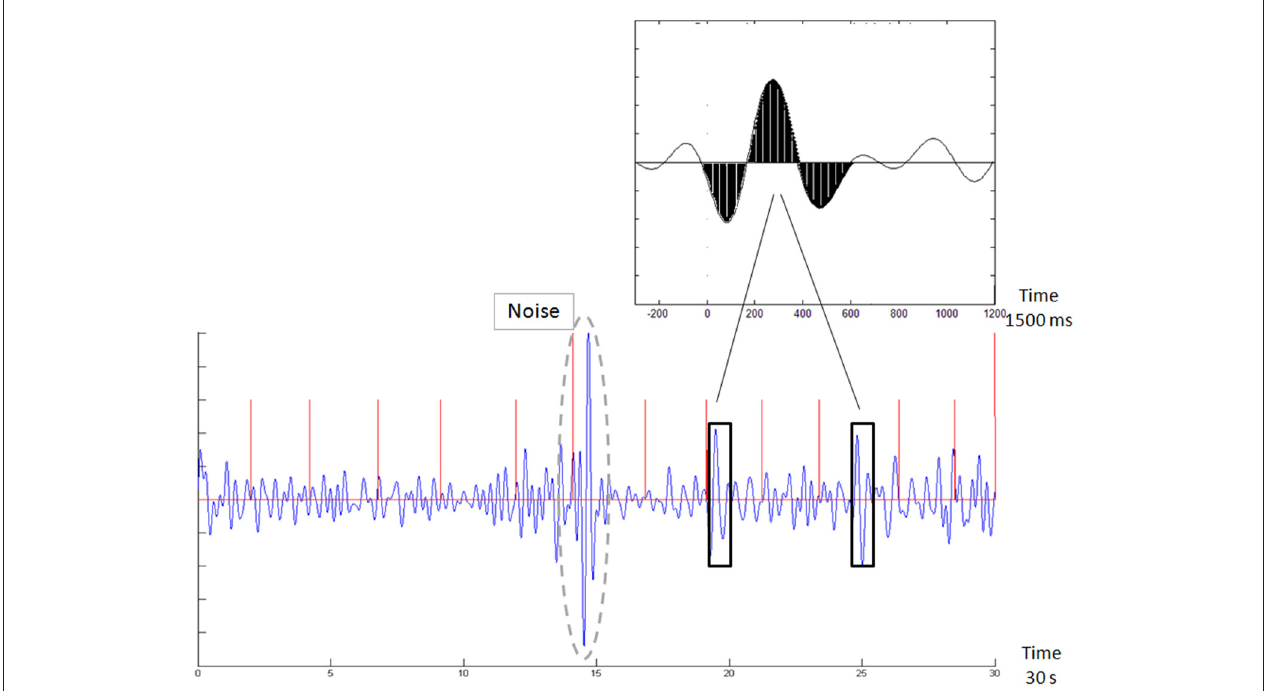
FIGURE 2 | Demonstration of template matching. The template is emphasized in black in the top inset. The new sample in the bottom chart is scanned with a moving window, following normalization to the [ − 1,1] range. Whenever a match is found (black rectangles), it is counted. Two such outstanding matches are emphasized by black rectangles. The brain engagement index (BEI) is a normalization of this count to the [0,1] range. The bottom chart also shows an automatically rejected noisy sample (surrounded by a dashed gray line). The red vertical lines denote the stimulus times.